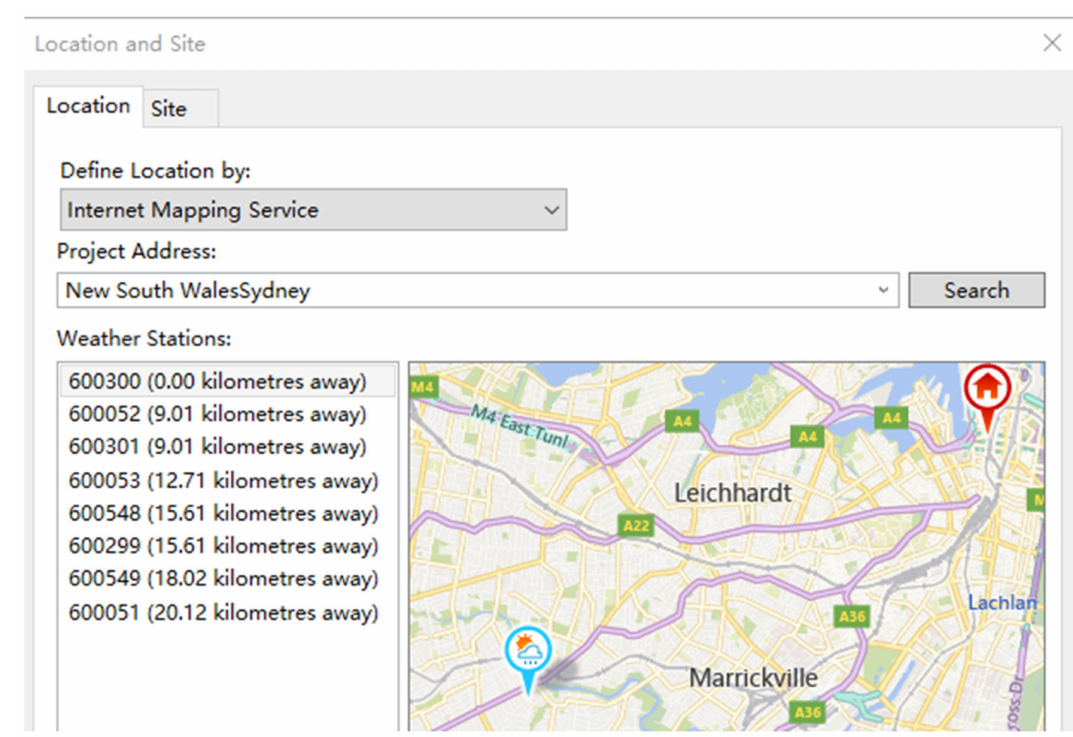
Figure A8. Case Study—Location setting in BIM.